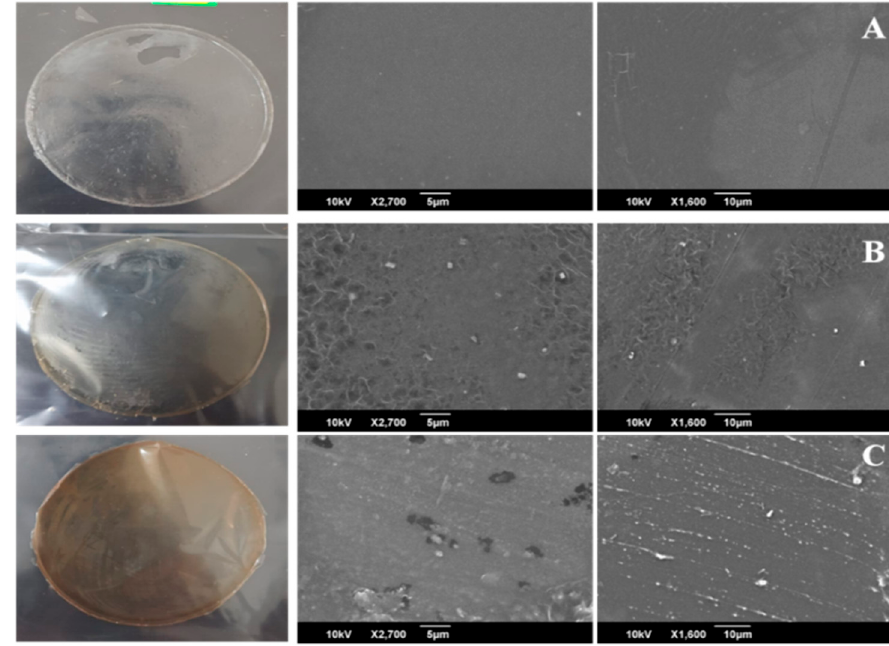
Figure 7. SEM images of ( A ) CG ( B ) CG1 ( C ) CG4.